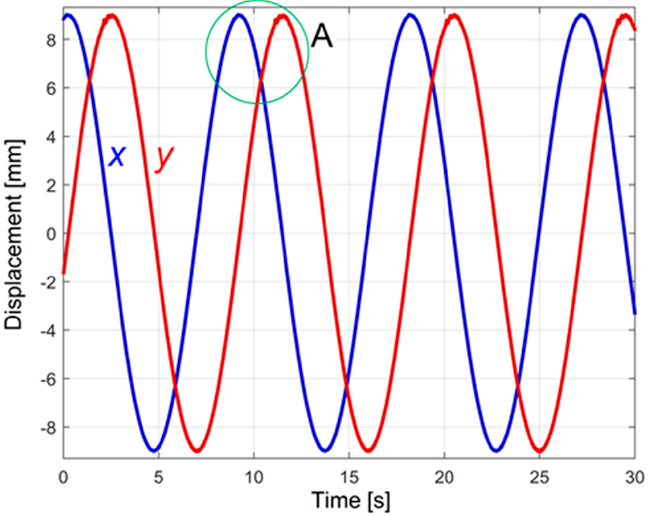
Figure 4. The evolution of x and y -motions during a repetitive circular trajectory.